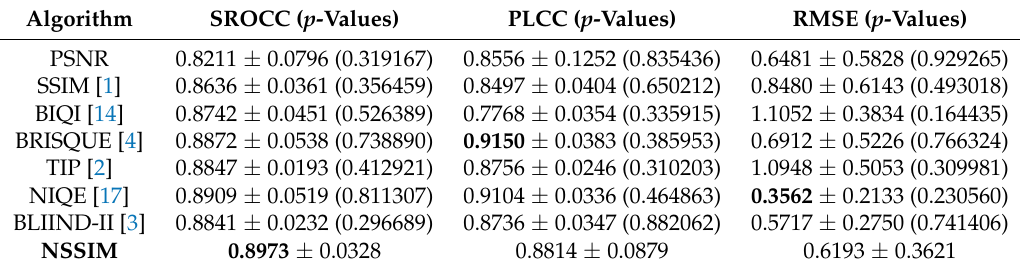
Table 10. Average IQA performance (mean ± standard deviation) on four datasets. We take Spearman’s rank order correlation coefficient (SROCC), Pearson linear correlation coefficient (PLCC) and root mean square error (RMSE) as evaluation indexes. In each column, the best performance value is marked in